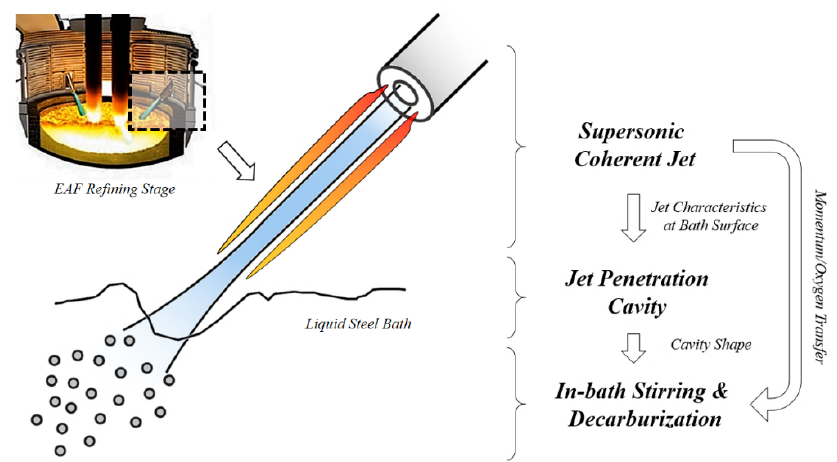
Figure 1. Methodology of developing the 3D integrated model for electric arc furnace (EAF) steel refining simulation. refining